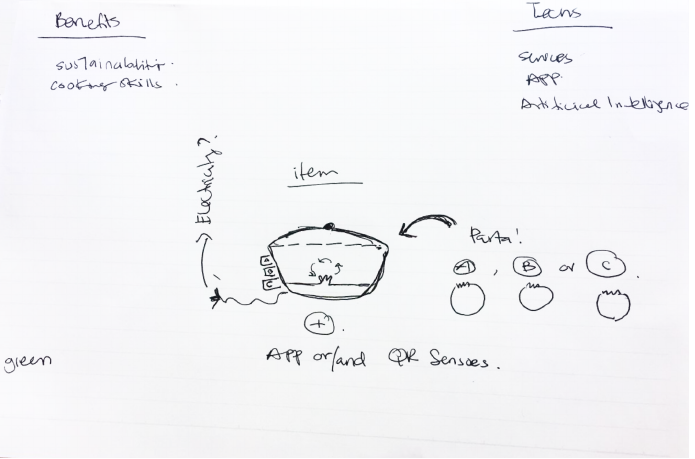
Figure 6. Design by P15 of a “smart pasta pot